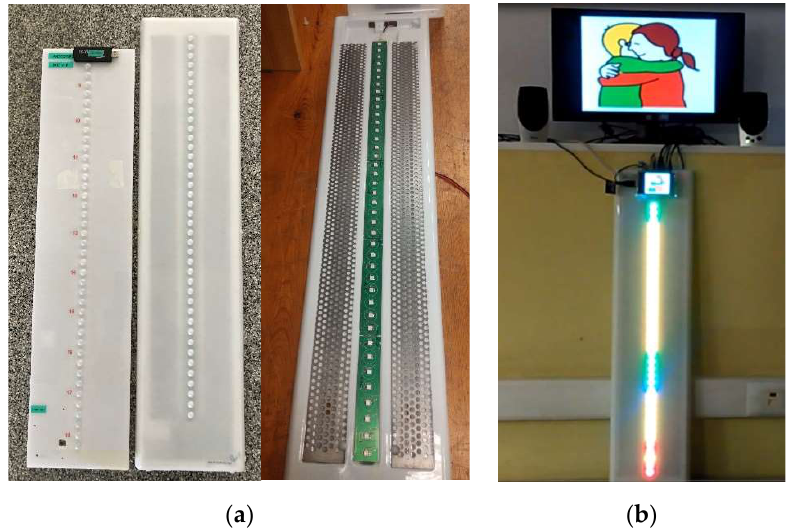
Figure 3. ( a ) TOD version 2: outside aspect and inside distribution; ( b ) TOD version 3: outside